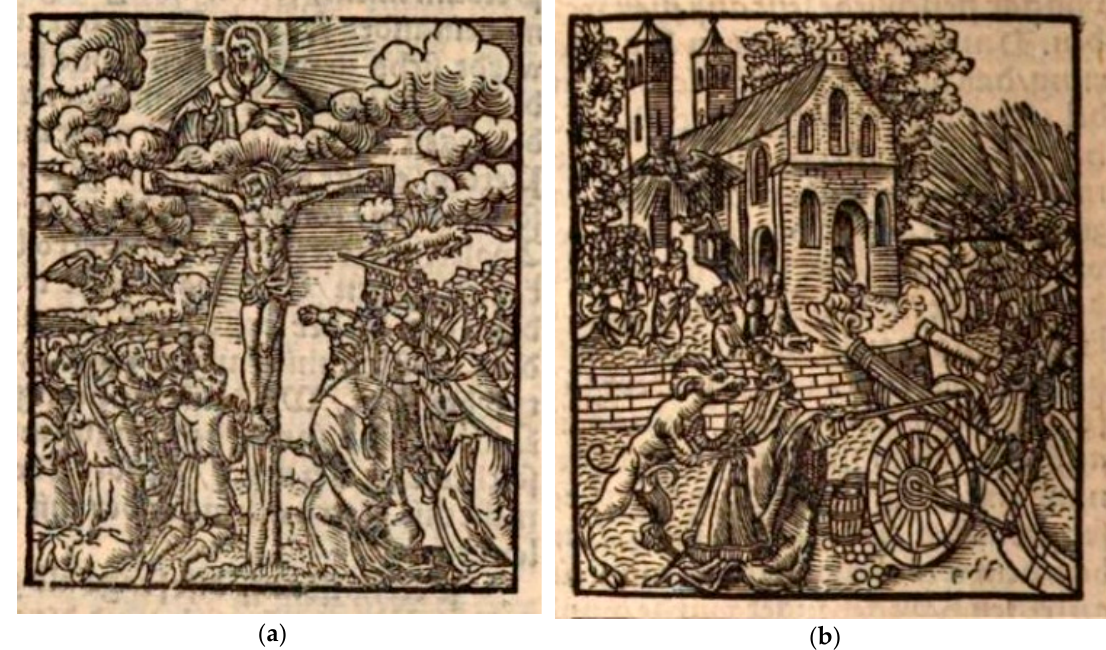
Figure 8. Woodcuts recurring in books published by vom Berg and Neuber. ( a ) Adoration of the Crucifix and Catholic hierarchs [S 65], in (Luther 1544b, part 3, fol. XLIII) (Munich, Bayerische Staatsbibliothek, 2 Hom. 277, urn:nbn:de:bvb:12-bsb10144039-2; NoC-NC/1.0); ( b ) Siege of the church [S 72], in (Luther 1544b, part 3, fol. LXXVv) (Munich, Bayerische Staatsbibliothek, 2 Hom. 277, urn:nbn:de:bvb:12- bsb10144039-2; NoC-NC/1.0).